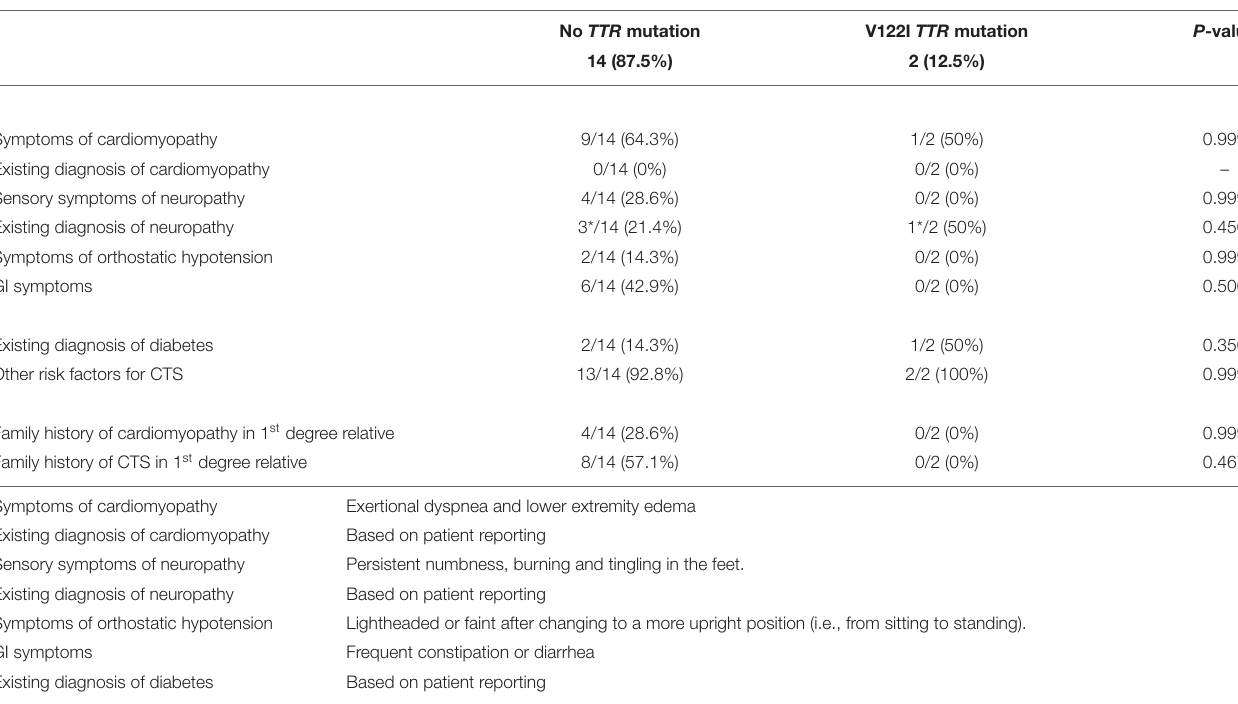
TABLE 2 | Association of red flag symptoms, CTS risk factors, and family history of CTS and cardiomyopathy with V122I TTR mutation vs. no